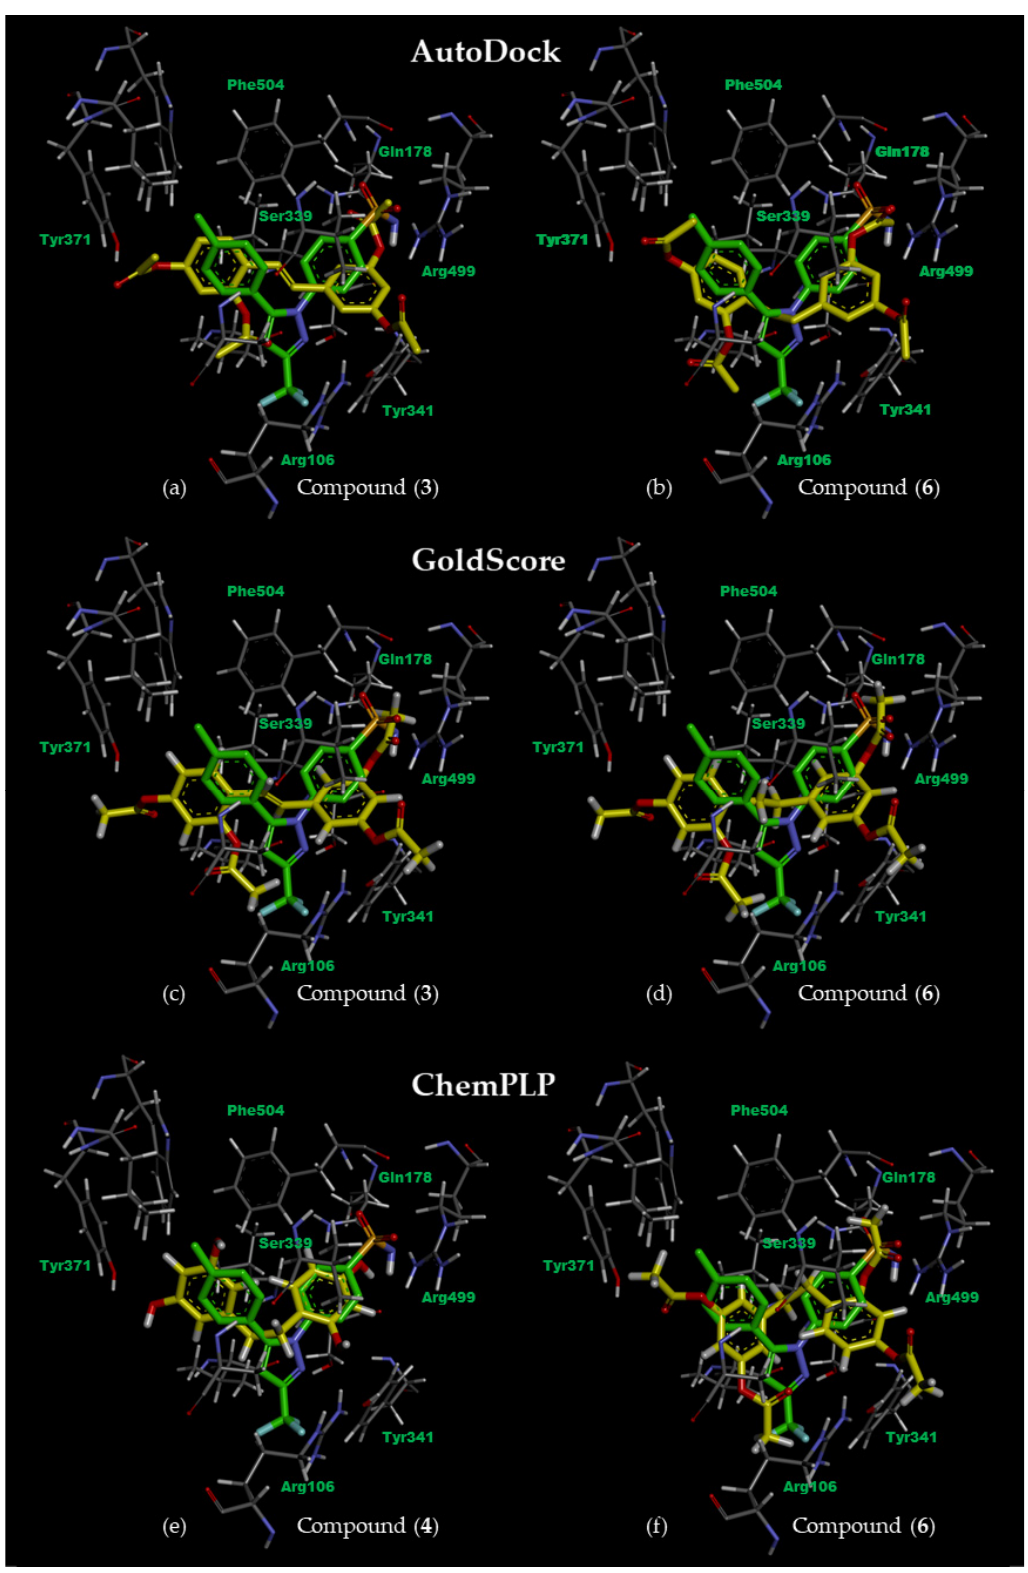
Figure 3. The best-docked poses (yellow) of oxyresveratrol analogues: ( a ) acetoxylated analogue ( 3 ) of oxyresveratrol and ( b ) acetoxylated analogue ( 6 ) of dihydrooxyresveratrol ranked by AutoDock; ( c ) compound 3 and ( d ) compound 6 ranked by GoldScore and ( e ) dihydrooxyresveratrol ( 4 ) and ( f ) compound 6 ranked by ChemPLP—were superimposed onto the relaxed pose of co-crystallized celecoxib (green). Some residues are omitted for clarity.